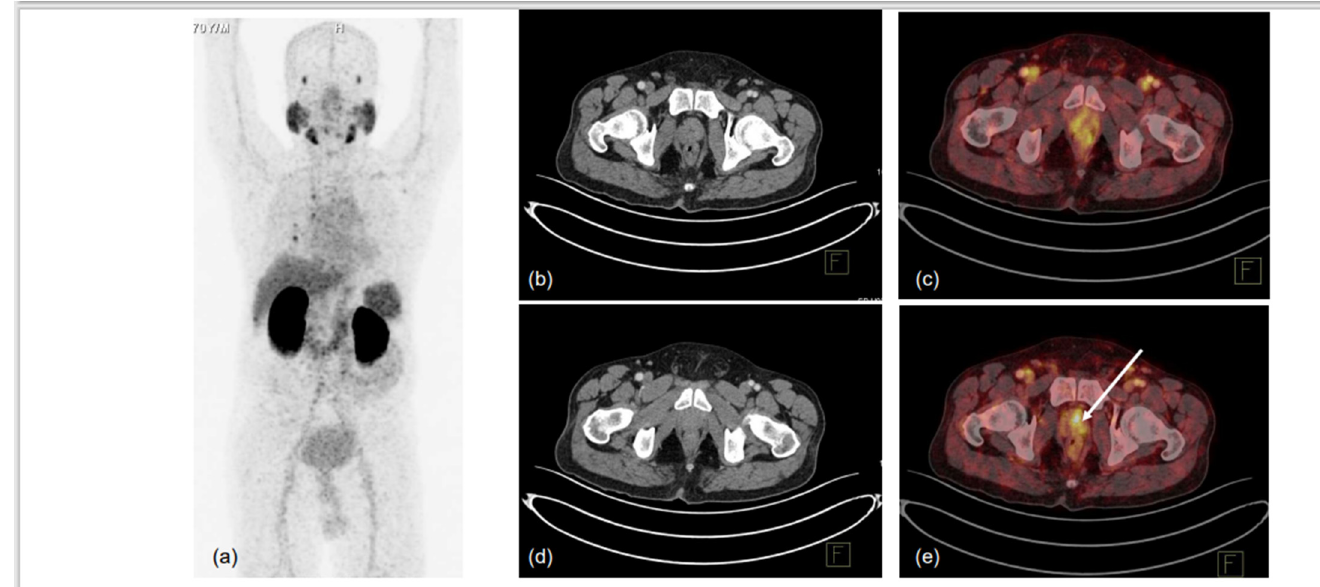
Figure 1. 70-year-old male, presented with difficulty in urination and lower urinary tract symptoms (LUTS). Serum PSA was 0.43 ng/mL. mpMRI of prostate was performed, which showed indeterminate lesion in right peripheral zone of mid-gland region. 68 Ga-PSMA-11 PET-CT was used to localise prostate lesion for targeted biopsy. MIP ( a ) showed low-grade PSMA uptake in prostate, with non-specific uptake in right lung and normal biodistribution. CT trans-axial slices and corresponding fused PET-CT trans-axial slices show mildly PSMA-avid hypodense lesion in right peripheral and central zones in mid-gland region (1.0 × 1.0 cm, SUVmax 5.6) ( b – e ). No locoregional or distant metastases were noted. TRUS-guided biopsy of PSMA-expressing lesion showed infiltrating acinar adenocarcinoma, Gleason grade 3 + 3/10. Arrow in ‘e’ denotes the PSMA-expressing area submitted for biopsy.